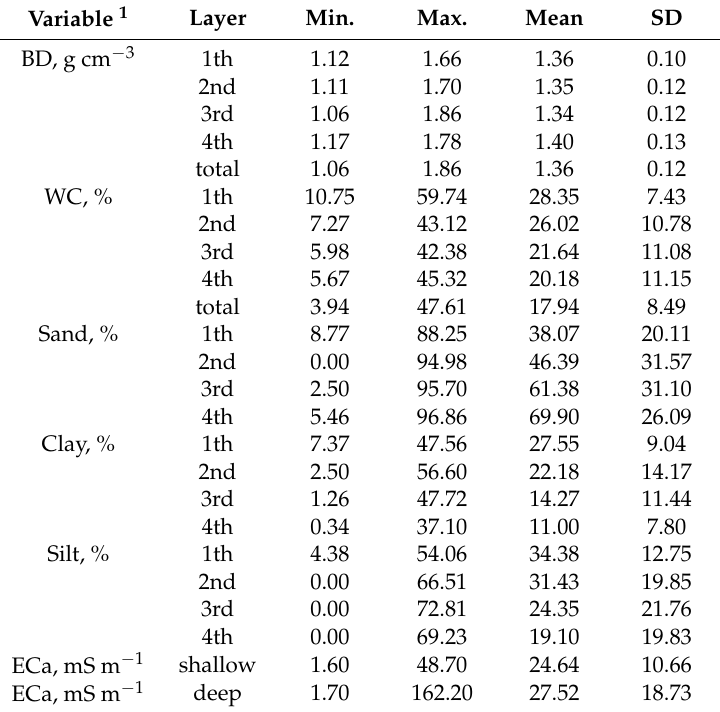
Table 4. Descriptive statistics for selected soil properties from different soil sampling layers. Soil samples were collected at four depths from 0–1 meter at 100